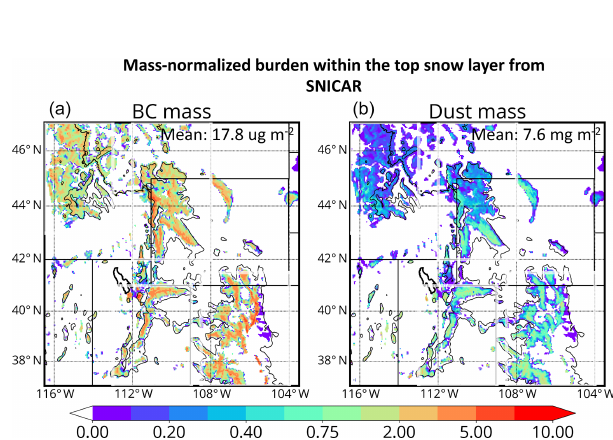
Figure 6. Top layer in-snow burdens for (a) BC and (b) dust nor- malized by their respective means (unitless). Means are computed for grid cells that have SWE values greater than 2mm in the March- through-June